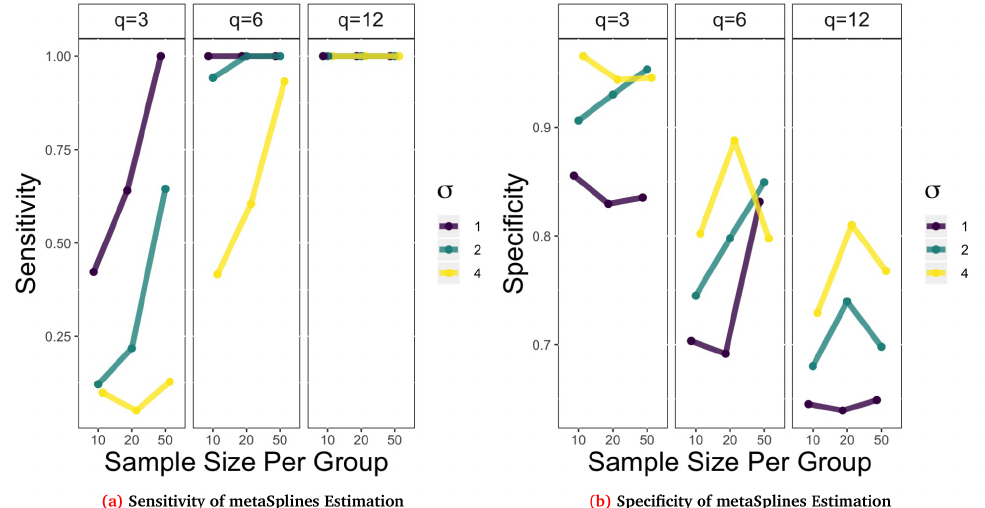
Figure 8. Sensitivity and specificity results for L_up Hockey Stick type trend for an AR(1) correlation structure with parameters: β = 1, IP = ( t +1)/2, ρ = 0.7. Remaining parameters were varied to create 27 different combinations q of repeated measurements, sample size per group, and σ . Points plot are the average result of B = 100 repetitions.